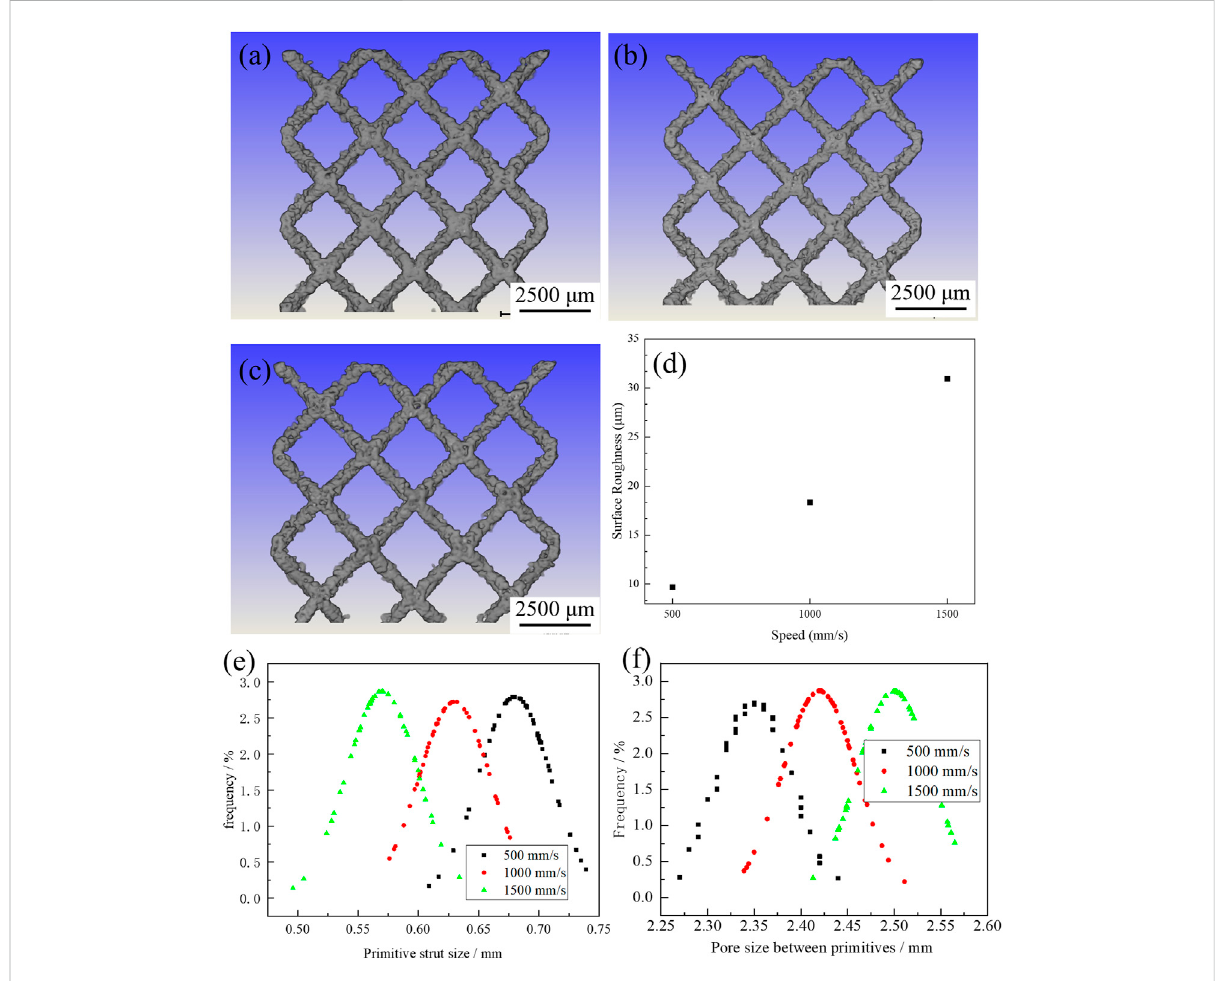
FIGURE 5 Micro-CT surface morphologies of the materials built at 500 mm/s (A) , 1,000 mm/s (B) , 1,500 mm/s (C) . Surface roughness (D) , strut size (E) , and pore size (F) of porous structures built at different laser scanning speeds.